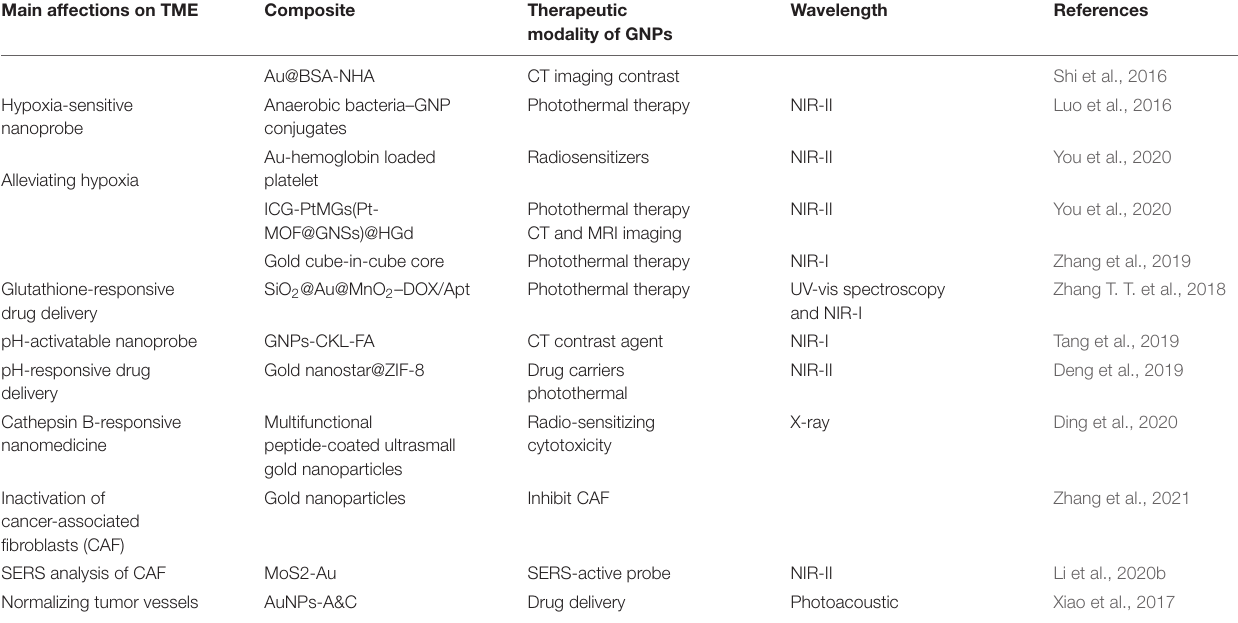
TABLE 2 | The applications of gold nanostructure in tumor